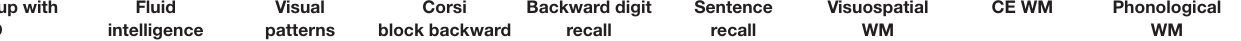
TABLE 3 | Pearson’s coefficients for the correlations between the fluid intelligence, the phonological working memory tasks, the visuo-spatial working memory tasks, and central executive for each group diagnosis. Group with